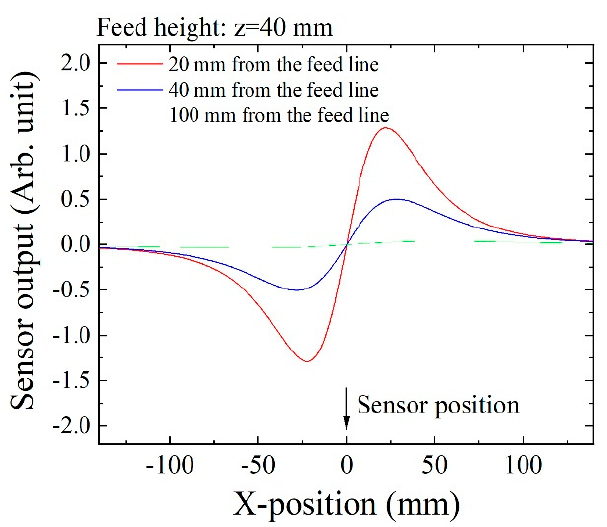
Figure 6. Numerically estimated sensing waveforms.